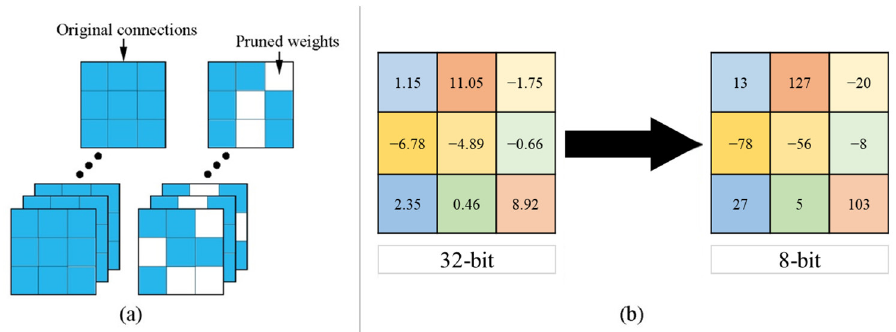
Figure 2. General process of ( a ) pruning and ( b ) quantization. Note that pruning shows an example of removing weights and quantization shows an example of converting 32-bit floating-point number to 8-bit integer.